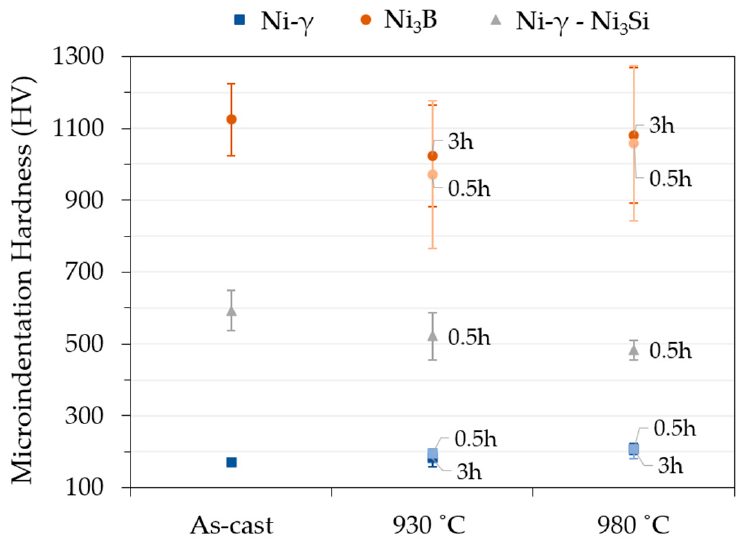
Figure 6. Microindentation hardness (HV) of the phases present in the as-cast and heat-treated microstructures in the range of 25 g to 100 g.